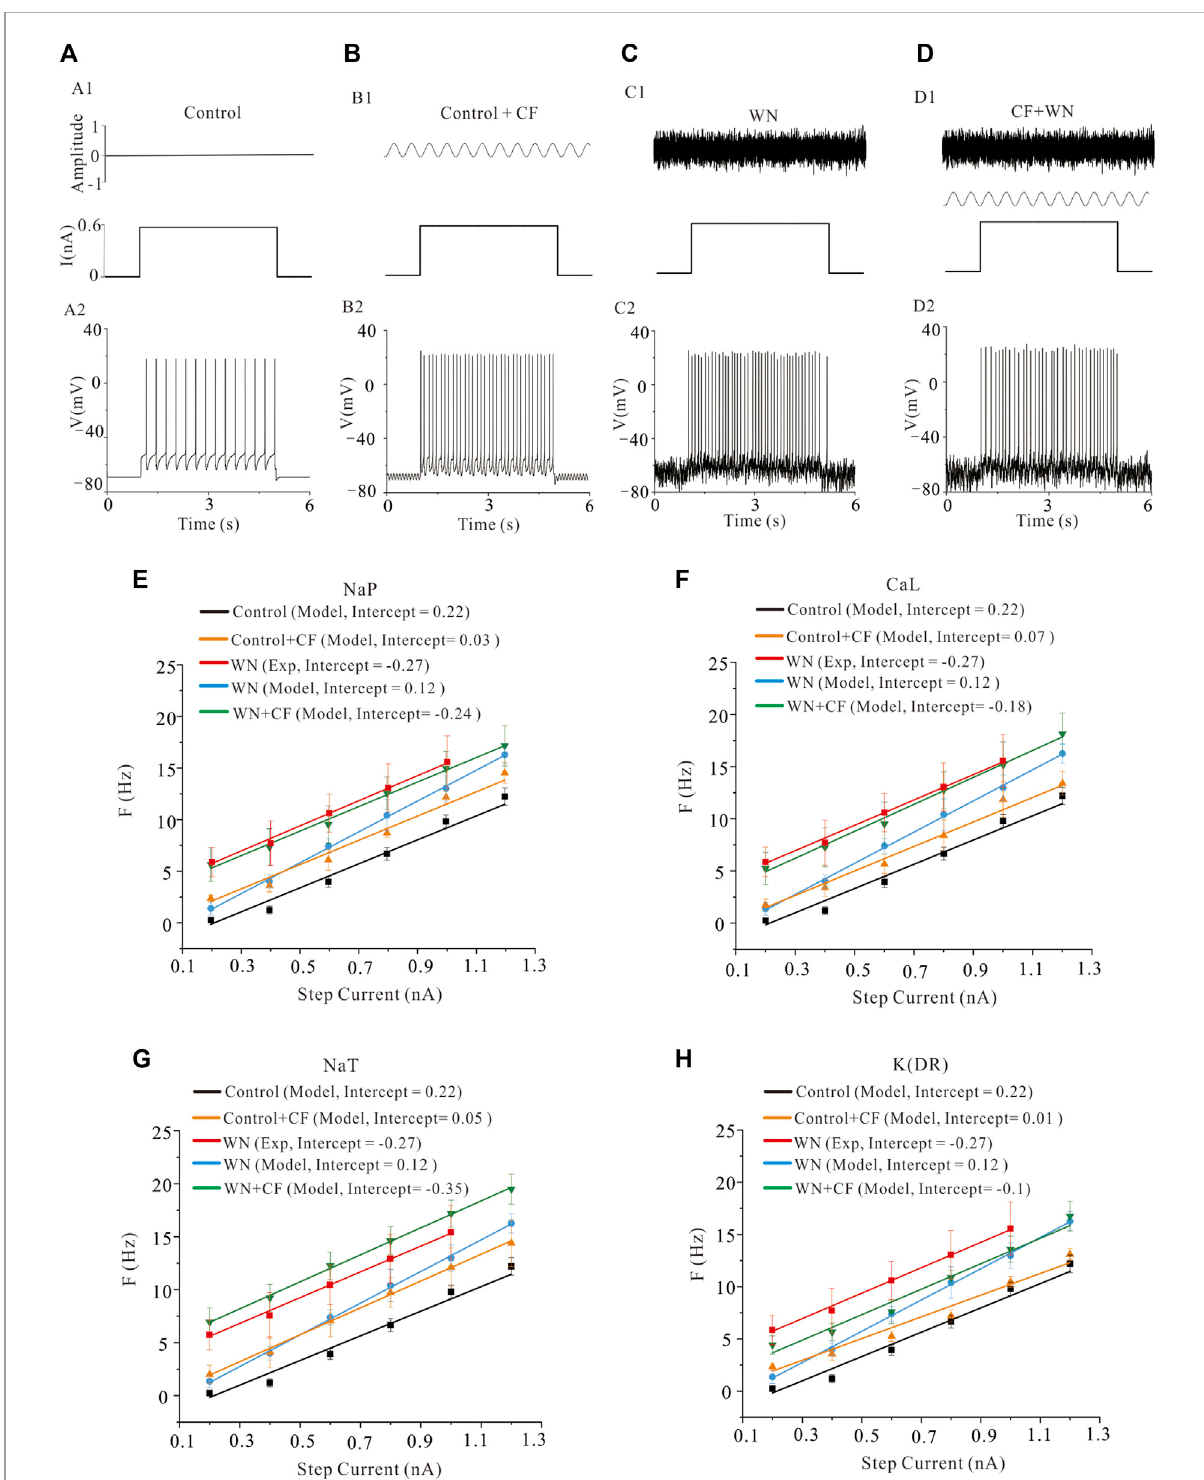
FIGURE 5 Effectofchannel fl icker(CF)ontheF-Irelationships. (A) Repetitive fi ring (A2) wasinducedbystepcurrents (A1) . (B) Repetitive fi ring (B2) induced by the same step currents with CF ( B1 , CF on top, step current on bottom). (C) : Repetitive fi ring (C2) induced by the same step currents with white noise ( C1 , WN on top, step current on bottom). (D) : Repetitive fi ring (D2) induced by the step currents with combination of white noise and CF (D1) . The WNwas shown ontop, step current andchannel fl ickerwaveform on bottom.Note:CFwas addedto kinetics ofionic channelsrather than injected currents. (E) : F-I relationships were established in fi ve conditions: rat experimental control data (red curve), model control (black curve), modelwithNaPchannel fl icker(orangecurve),modelwithwhitenoise(bluecurve)andmodelwithwhitenoiseplusCFaddedtoNaPchannel(green